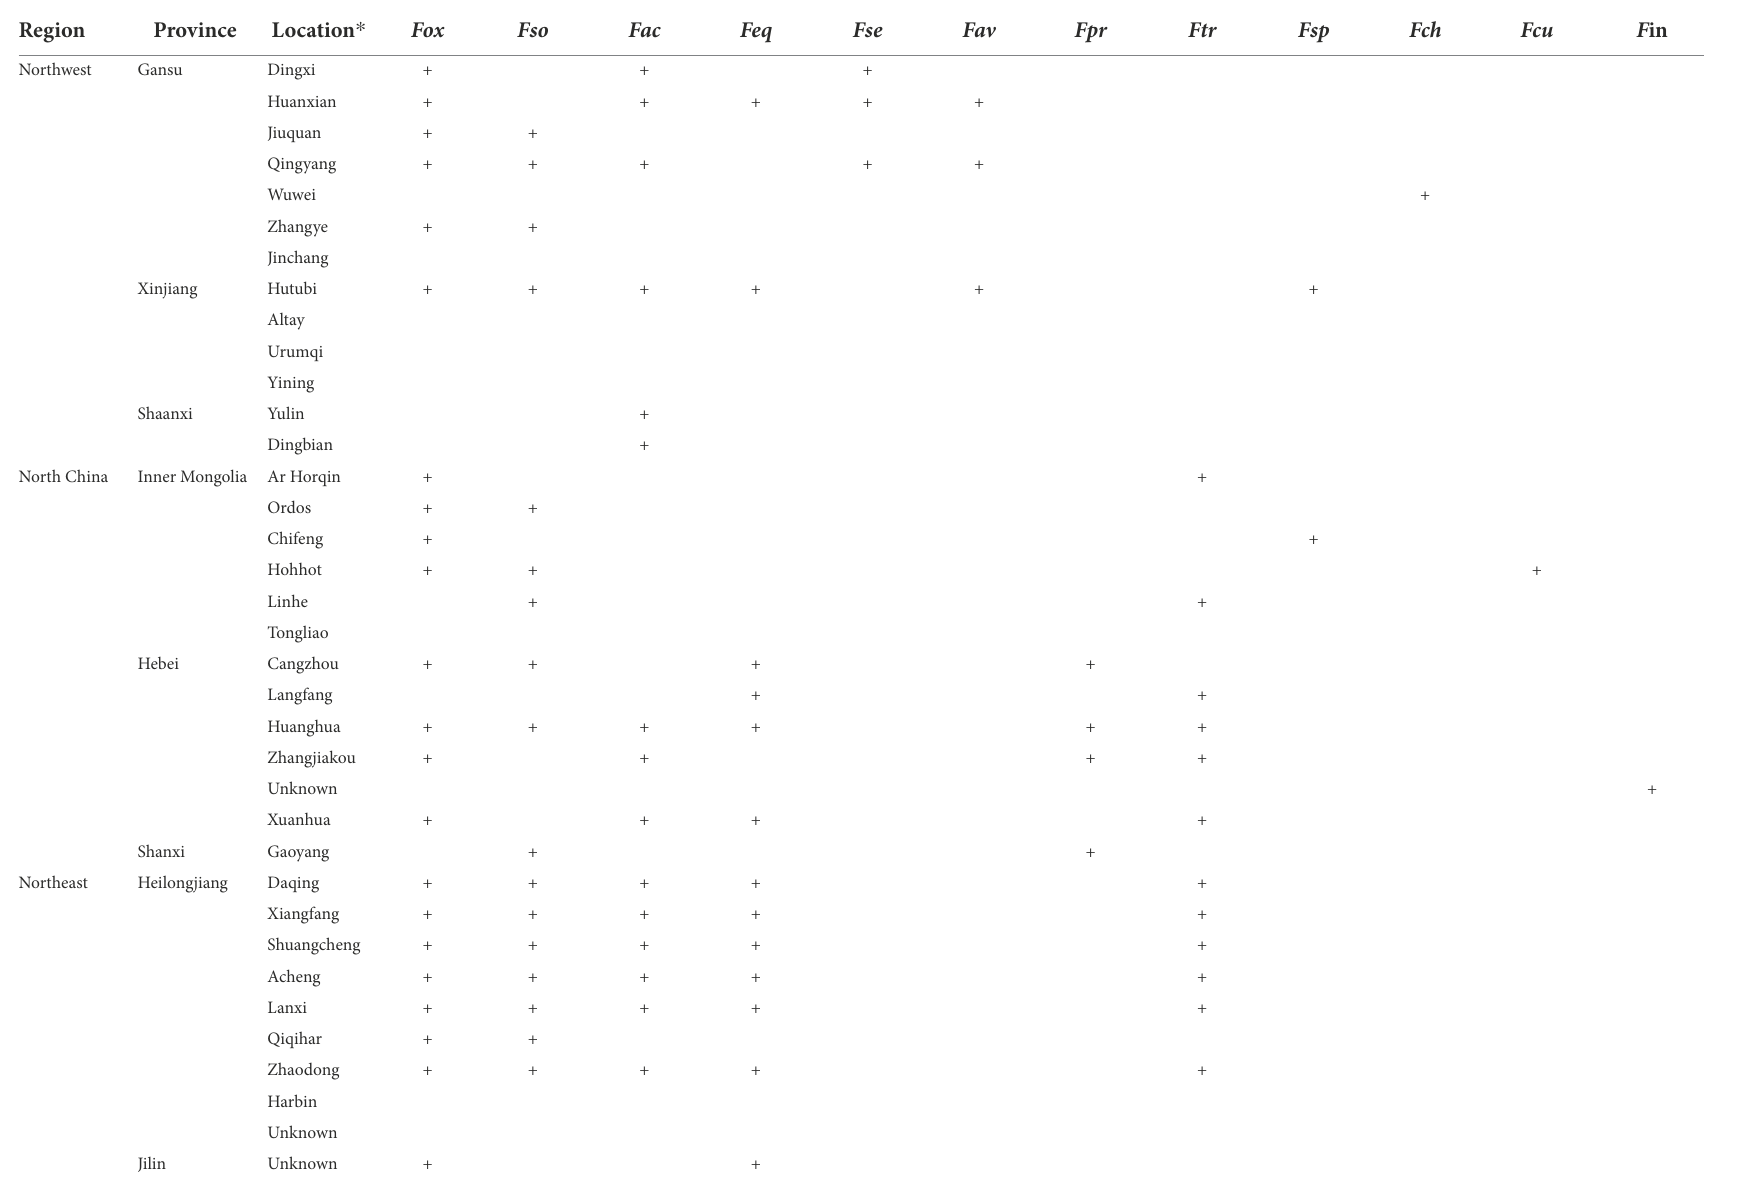
TABLE 1 Distribution of Fusarium spp. in the alfalfa-growing areas of China. Region Northwest